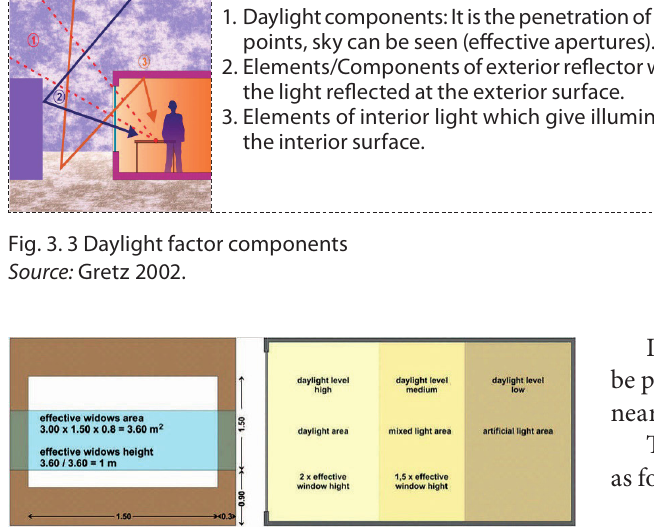
Fig. 4. Dimming and lighting level area Source: Huddleston